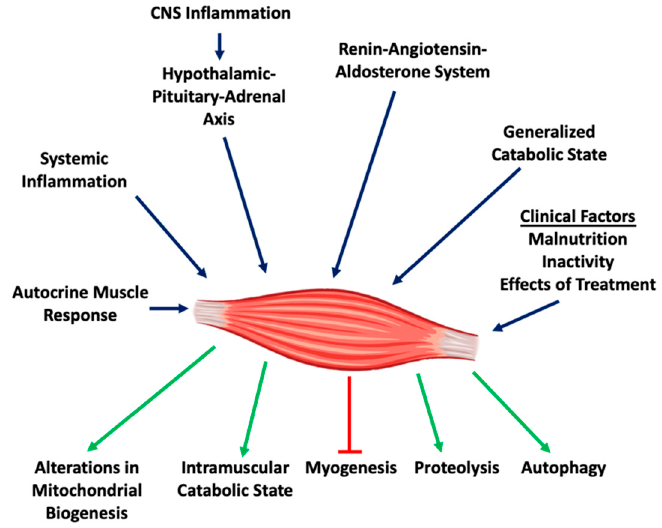
Figure 1. General mechanisms contributing to the pathogenesis of muscle wasting.